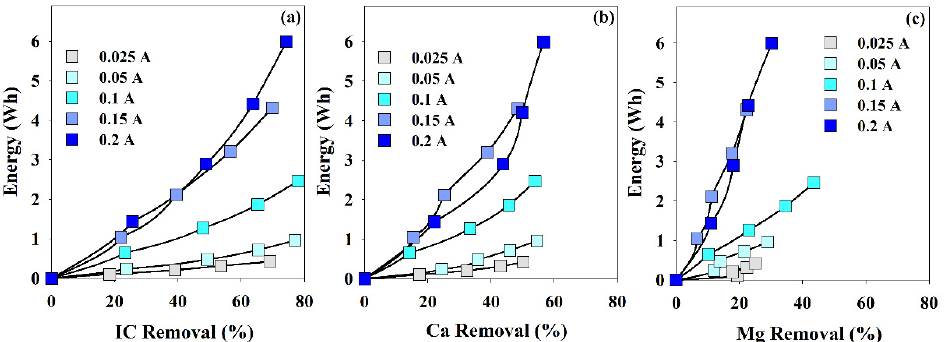
Figure 4. Energy consumption vs. removal percentage of ( a ) IC, ( b ) Ca 2+ and ( c ) Mg 2+ , during the assays performed at different current intensities. I = 0.025 to 0.2 A; Anode—BDD 20 cm 2 ; Cathode—SS 20 cm 2 ; Stirring speed—1000 rpm; 4 h.